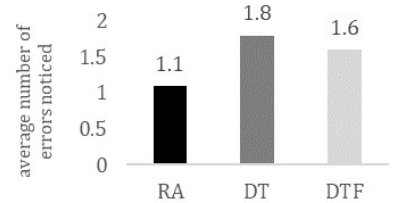
Figure12. Average number of errors noticed by the expert.